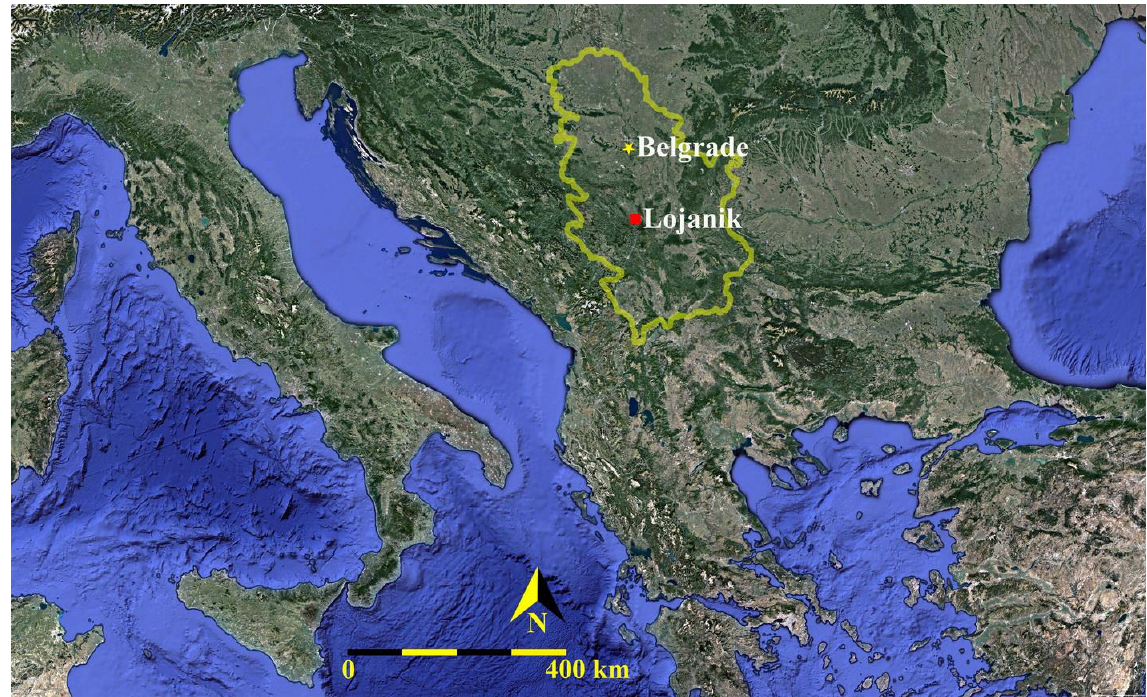
Figure 1. Position of the Lojanik quarry within a wider area. (From Google Earth).